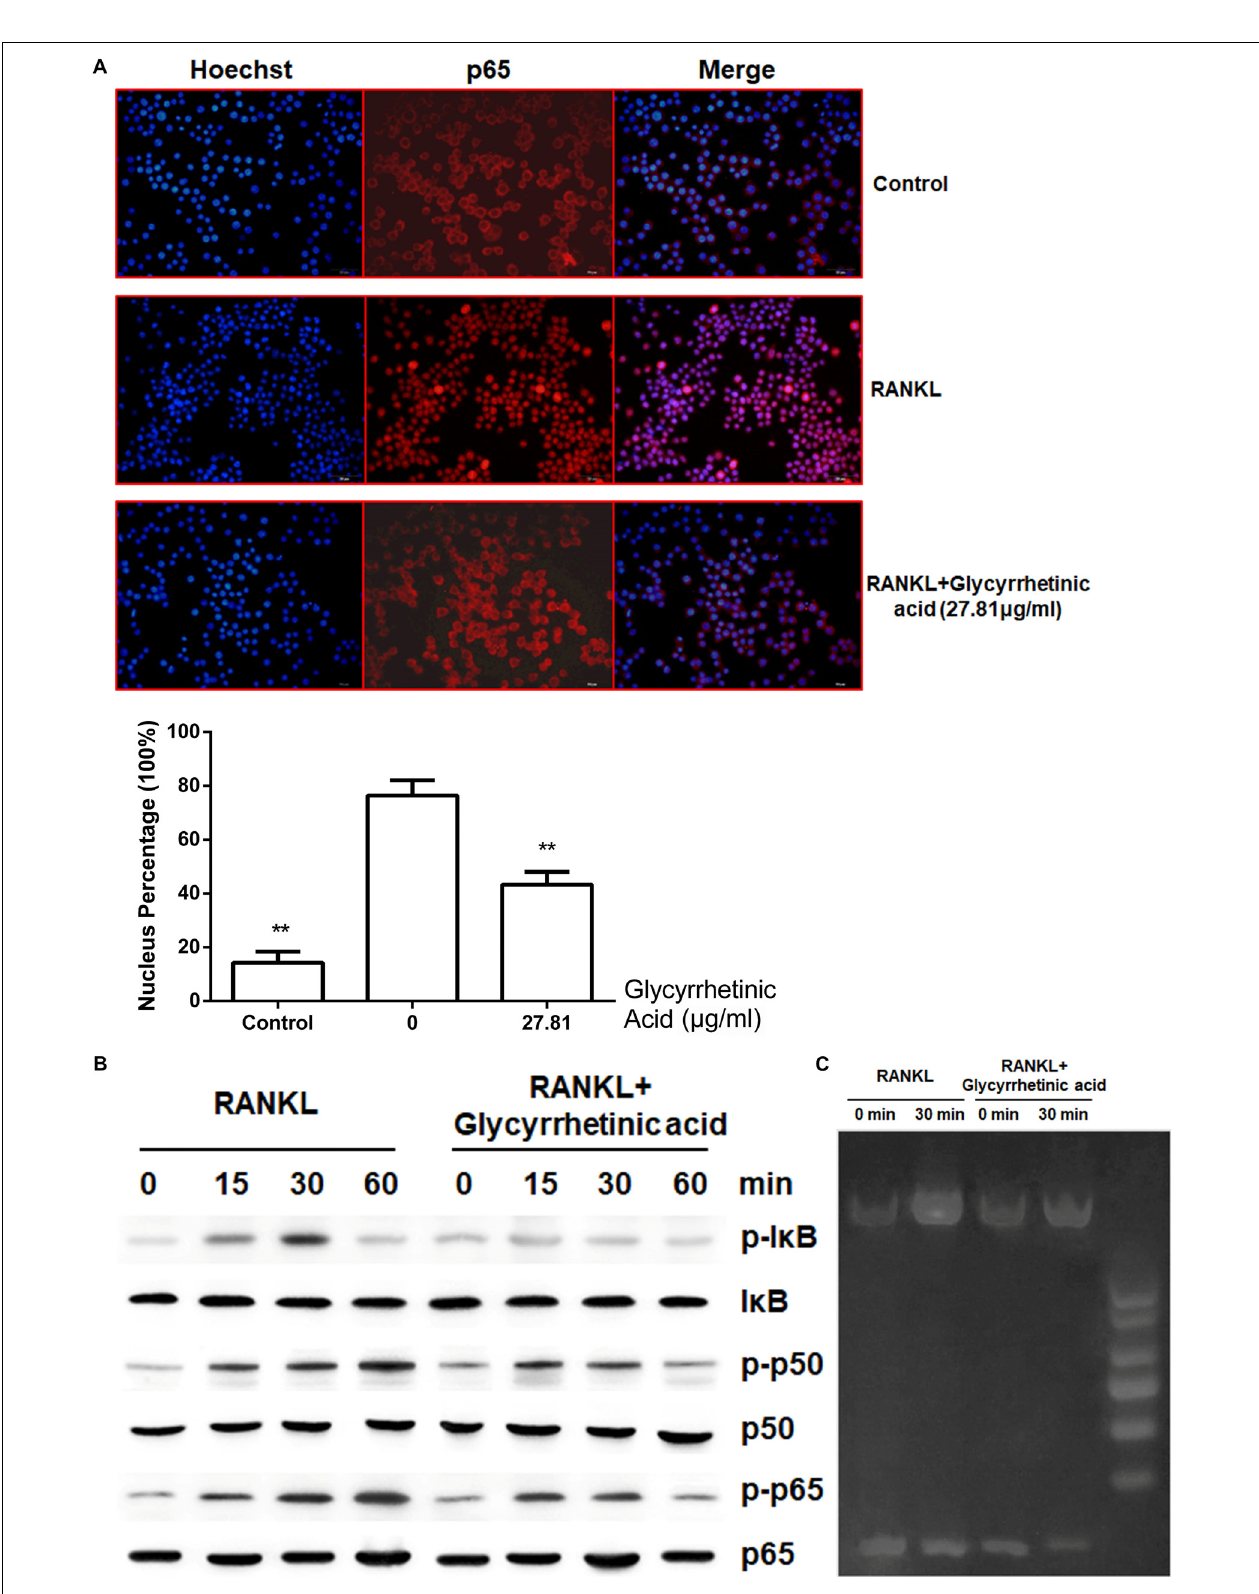
FIGURE 4 | 18 β -GA inhibits RANKL-induced activation of NF- κ B pathway. (A) 18 β -GA inhibits RANKL-induced P65 nuclear translocation. (B) Phosphorylation of P65, P50, and I κ B protein, which were associated with the NF- κ B pathway. (C) The DNA-binding activity of NF- κ B.